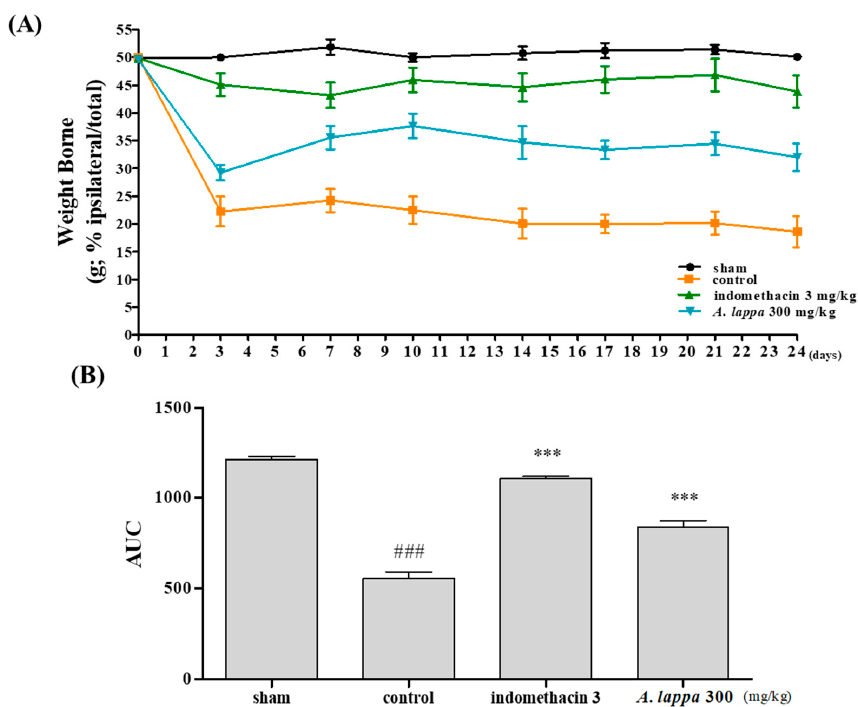
Figure 2. The effects of Aucklandia lappa on the hind paw weight-bearing capacities in monosodium-iodoacetate (MIA)- induced OA rats. ( A ) Weight-bearing ratios of the rats from 0–24 days with 3 mg/kg indomethacin or 300 mg/kg Aucklandia lappa and ( B ) AUC (area under the curve) measured with incapacitance meter tester. The significance was considered as ### p < 0.001 vs. sham, *** p < 0.001 vs. control.